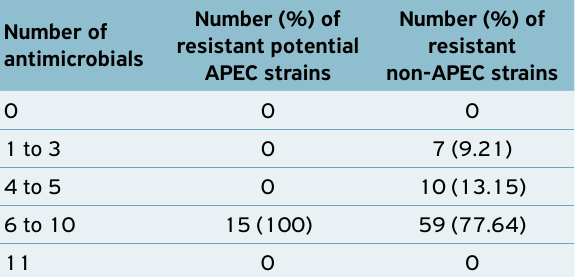
Table 2. Multiresistance levels of potential avian and non- avian pathogenic Escherichia coli strains isolated from the poultry